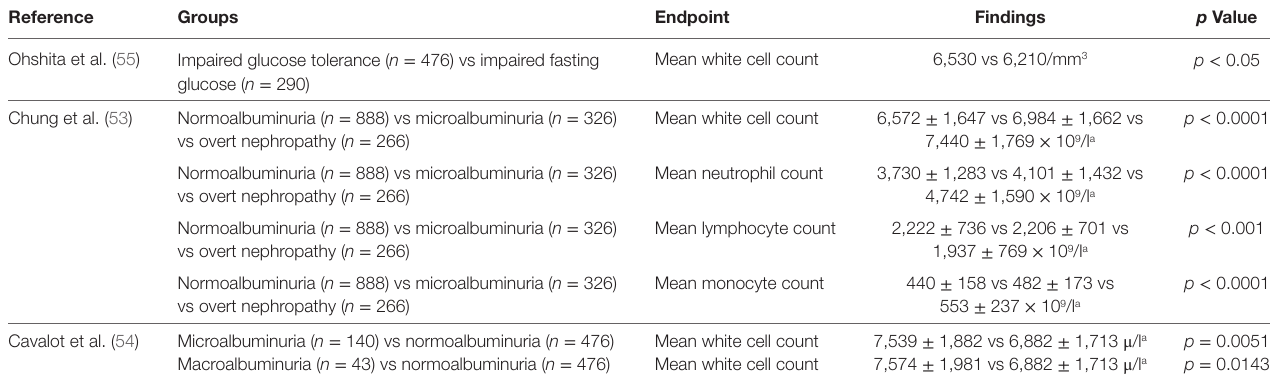
TABLe 3 | Cross-sectional studies of the white cell count in type 2